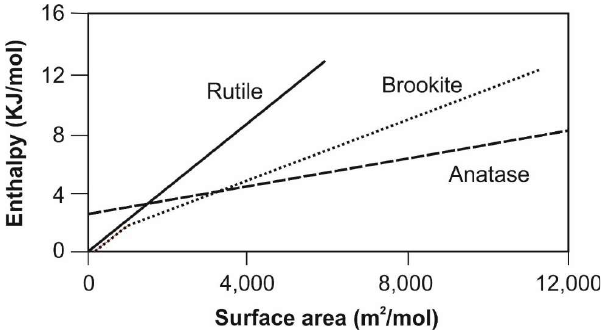
Figure 4. Enthalpy of titania polymorphs as a function of surface area (already presented in Reference [10], redrawn after Reference [34], following Reference [35]). Although the crystalline polymorph rutile is thermodynamically the most stable one, anatase and brookite are often slightly metastable by only a few kilojoules per mole. Brookite has a surface enthalpy of approximately 1.0 J/m 2 , which is higher than for anatase (0.4 J/m 2 ). Moreover, for titania particles with a surface area higher than around 4000 m 2 /mol (thus for smallest particles), anatase has the lowest enthalpy and can directly transform into brookite [35]. At a crossover size of about 30 nm, anatase nanoparticles may directly transform into rutile [34,36].